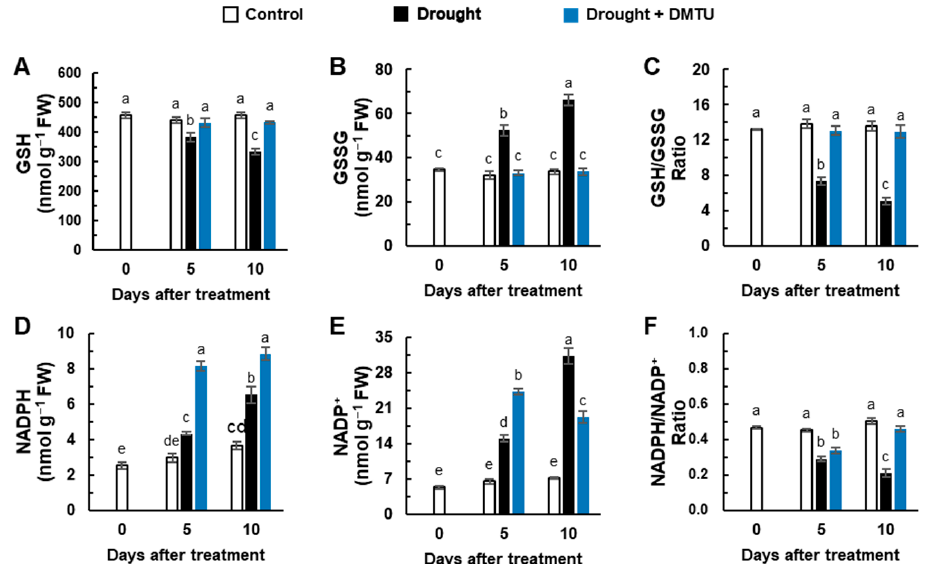
Figure 4. The changes of redox status in the leaves of Brassica napus under control, drought, or drought with dimethylthiourea (Drought + DMTU) treatments for 10 days. The concentrations of ( A ) GSH and ( B ) GSSG, ( C ) the ratio of GSH to GSSG, ( D ) the concentrations of NADPH and ( E ) NADP + , and ( F ) the ratio of NADPH to NADP + . Results are represented as mean ± SE for n = 3. Means with different letters are significantly different at p < 0.05, according to Duncan’s multiple range test.